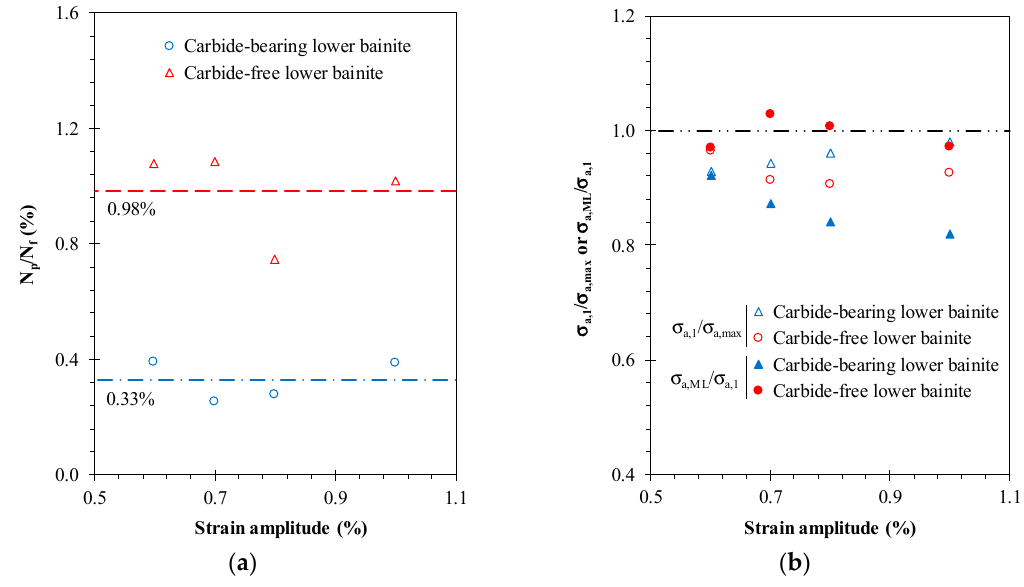
Figure 3. Variation of the: ( a ) N p / N f ratio with the strain amplitude; ( b ) σ a , 1 / σ a , max and the σ a , ML / σ a , 1 ratios with the strain amplitude.